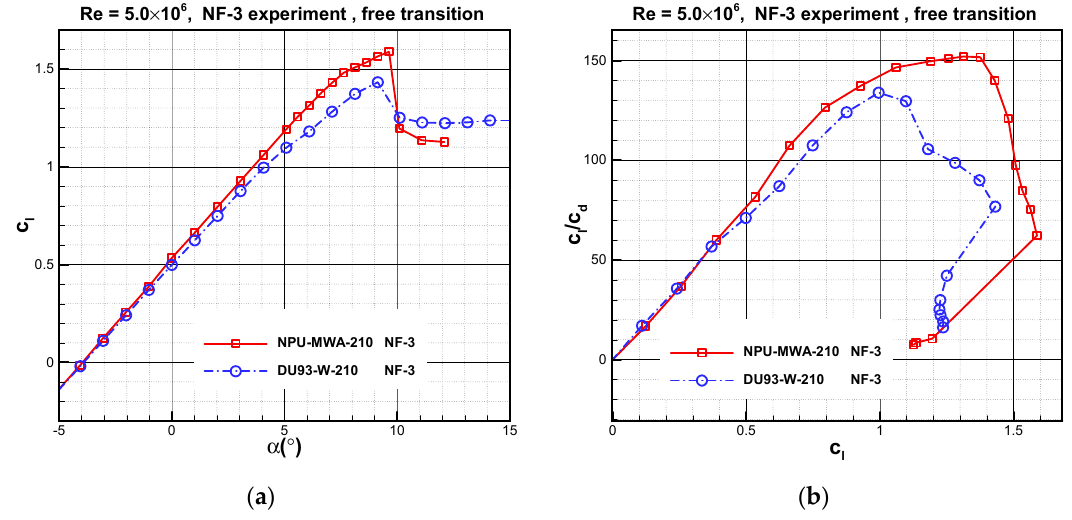
Figure 4. Comparison of experimental data for the NPU-MWA-210 airfoil and DU93-W-210 airfoil: ( a ) lift curves; ( b ) lift-to-drag ratio curves.